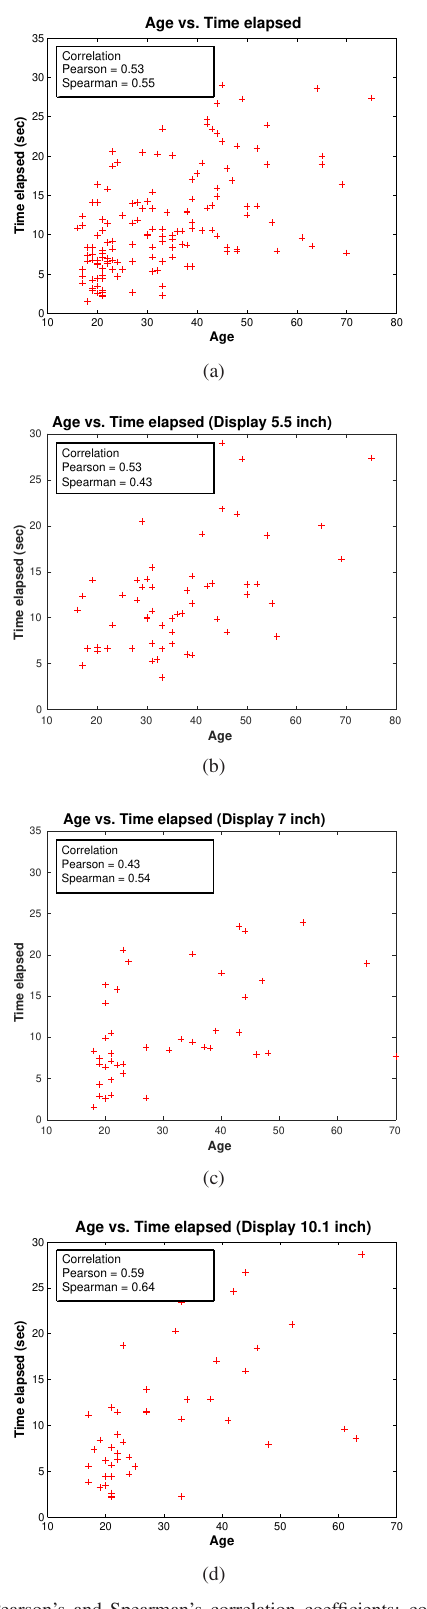
Figure 8. Pearson’s and Spearman’s correlation coefficients: correlation be- tween age and volunteer performance in accomplishing tasks of experiments. .